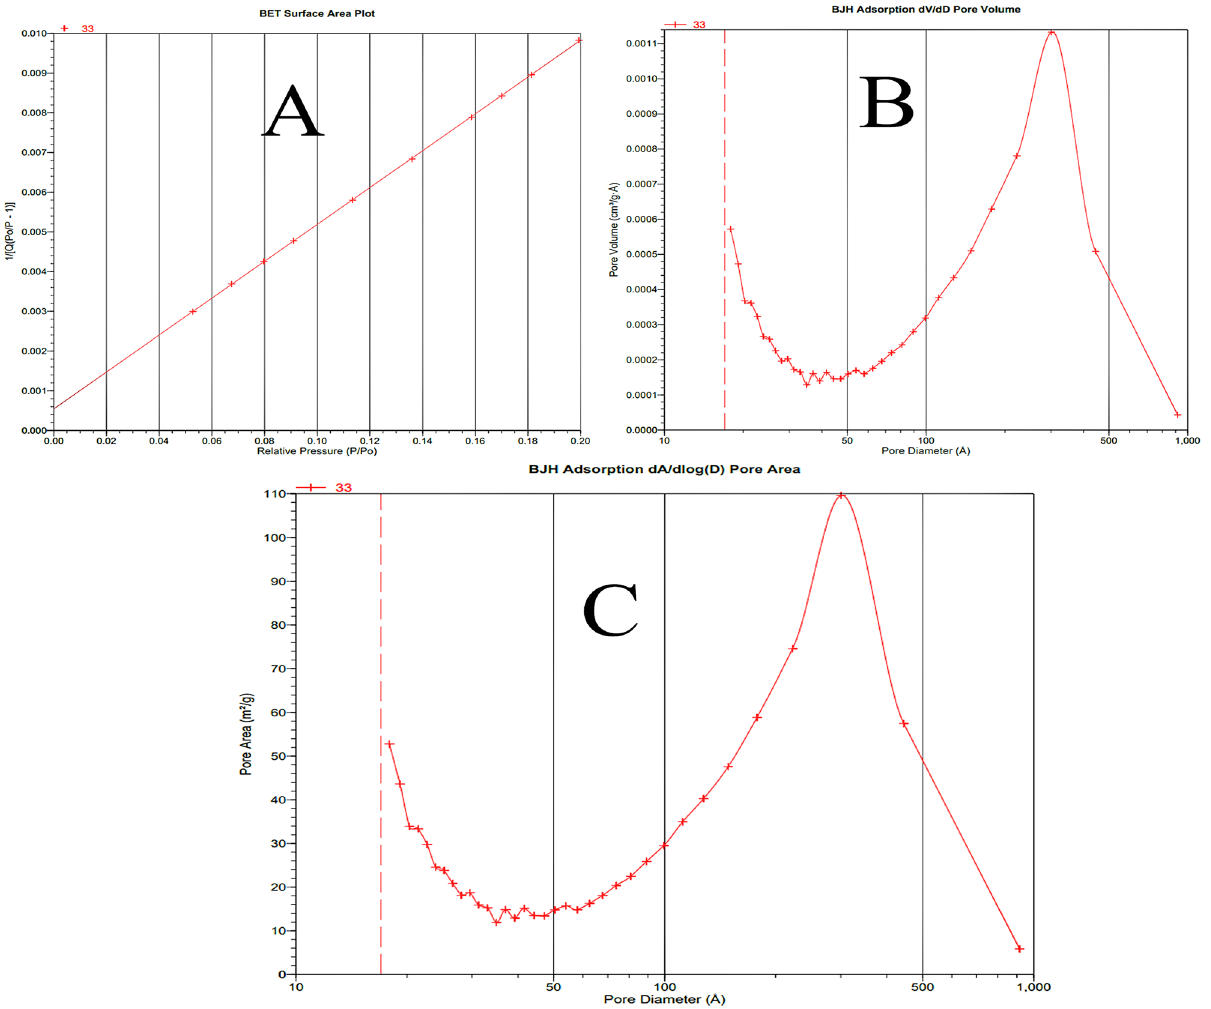
Figure 4. The BET surface area ( A ), BJH adsorption (dV/dD) pore volume ( B ), and BJH adsorption dA/dlogD pore area ( C ) of the composite. Reaction